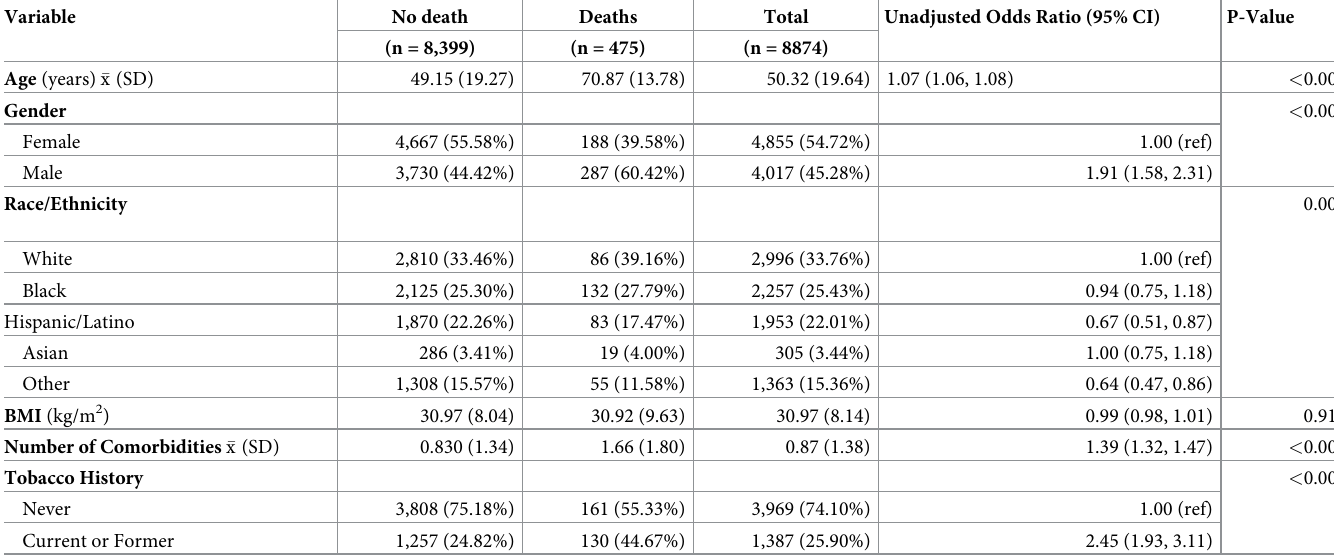
Table 1. Descriptive findings of patients in